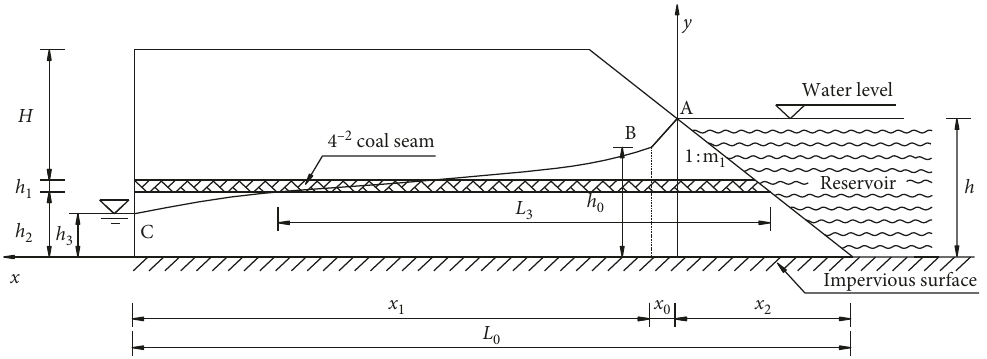
Figure 4: A simplified model for calculating the saturation